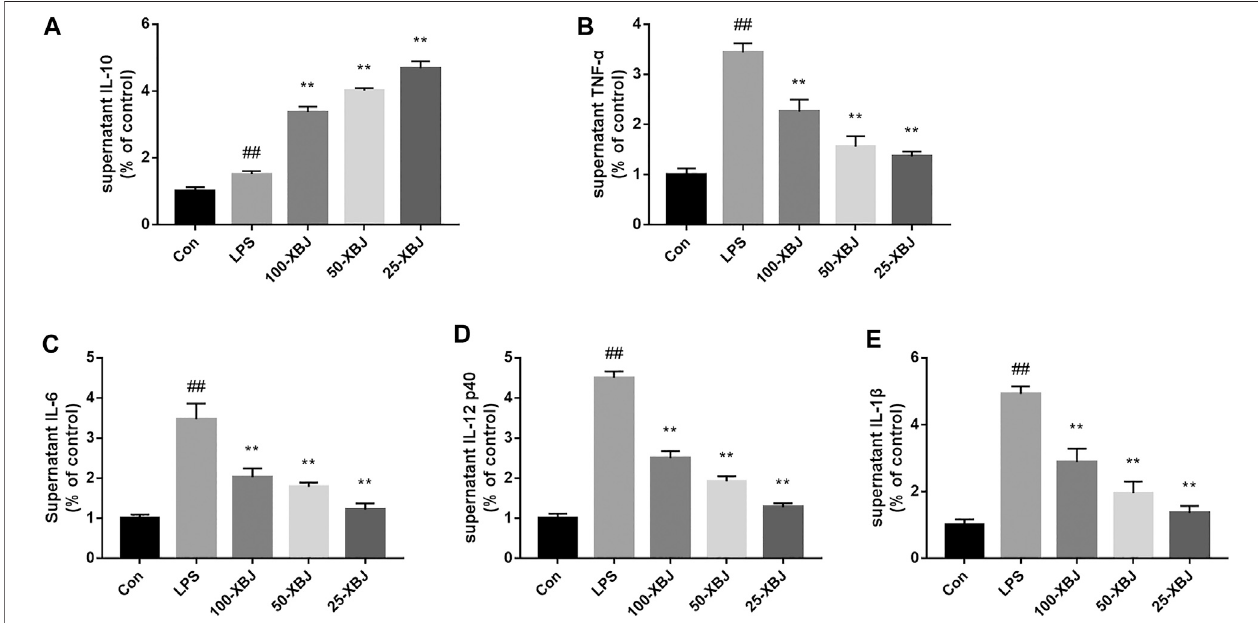
FIGURE 6 | XBJ modulates the levels of in fl ammatory factors in LPS-induced ALI cells (A) XBJ increased IL-10 in RAW264.7 cells with LPS-induced ALI. (B) XBJ decreased TNF- α in RAW264.7 cells with LPS-induced ALI (C) XBJ decreased IL-6 in RAW264.7 cells with LPS-induced ALI. (D) XBJ decreased IL-12 in RAW264.7 cells with LPS-induced ALI. (E) XBJ decreased IL-1 β in RAW264.7 cells with LPS-induced ALI. Con: control group without LPS treatment; LPS: model group with LPS treatment; 100-XBJ: group with LPS treatment + XBJ injection diluted 100 times; 50-XBJ: group with LPS treatment + XBJ injection diluted 50 times; 25-XBJ: group with LPS treatment + XBJ injection diluted 25 times. Compared with the control group, # p < 0.05, ## p < 0.01 were considered to be signi fi cant; Compared with the CLP group, * p < 0.05, ** p < 0.01 were considered to be signi fi cant. Data are expressed as mean ±